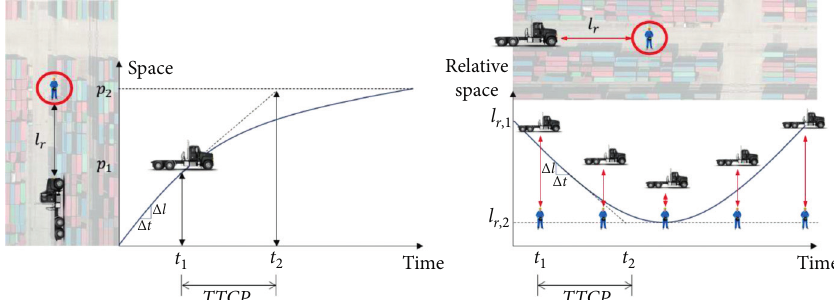
Figure 4: Risk detection algorithm with TTCP.